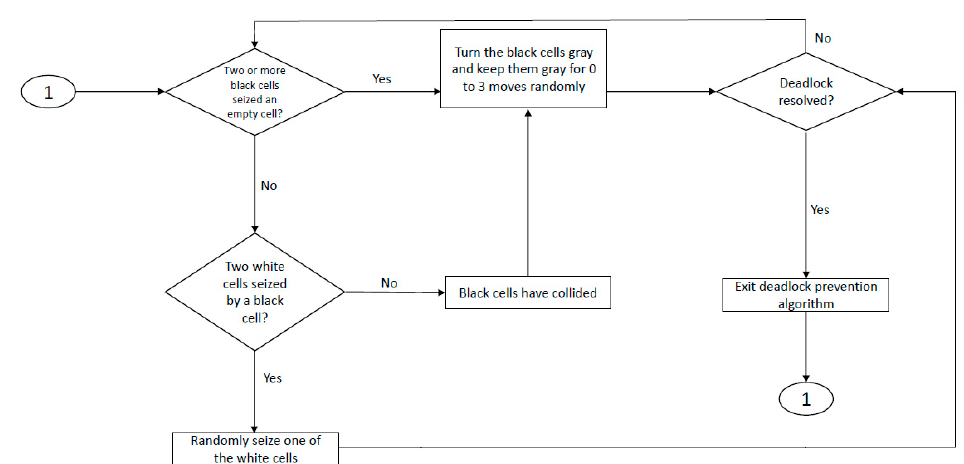
Figure 8. Main algorithm.